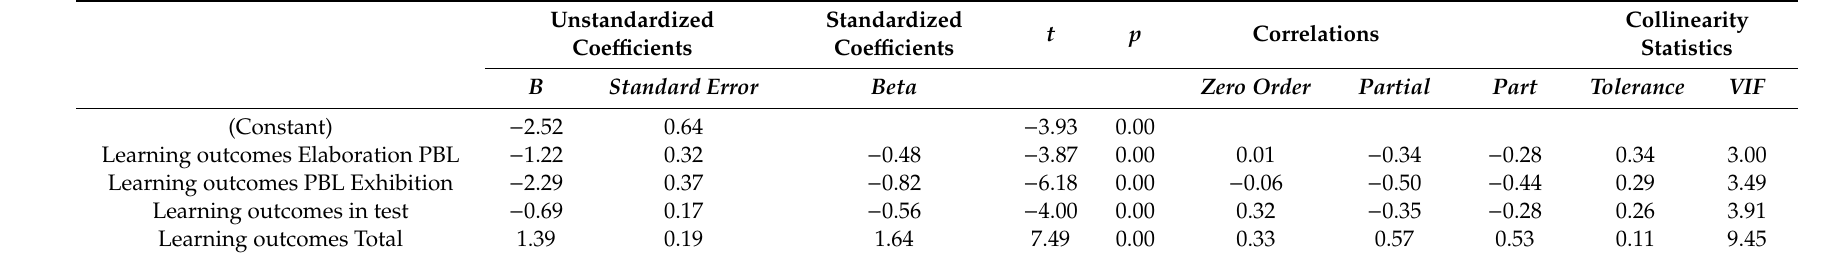
Table A3. Coe ffi cients in the prediction of learning outcomes with variable types of Blended Learning.